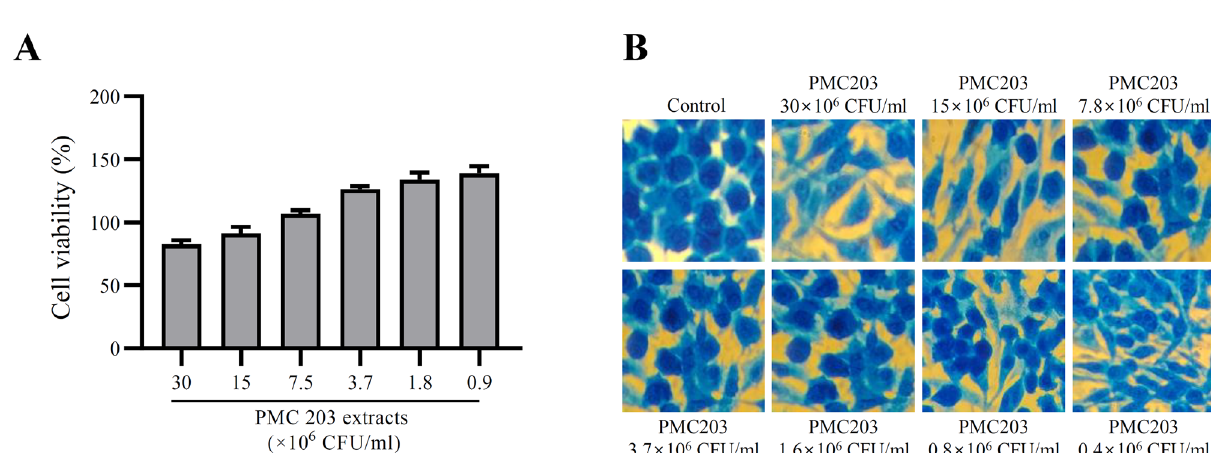
Figure 7. Cell cytotoxicity evaluation of PMC203 on macrophage cell lines. Cytotoxicity of PMC203 cell extract was evaluated at a wide range of concentrations against macrophage Raw 264.7 cell lines by ( A )